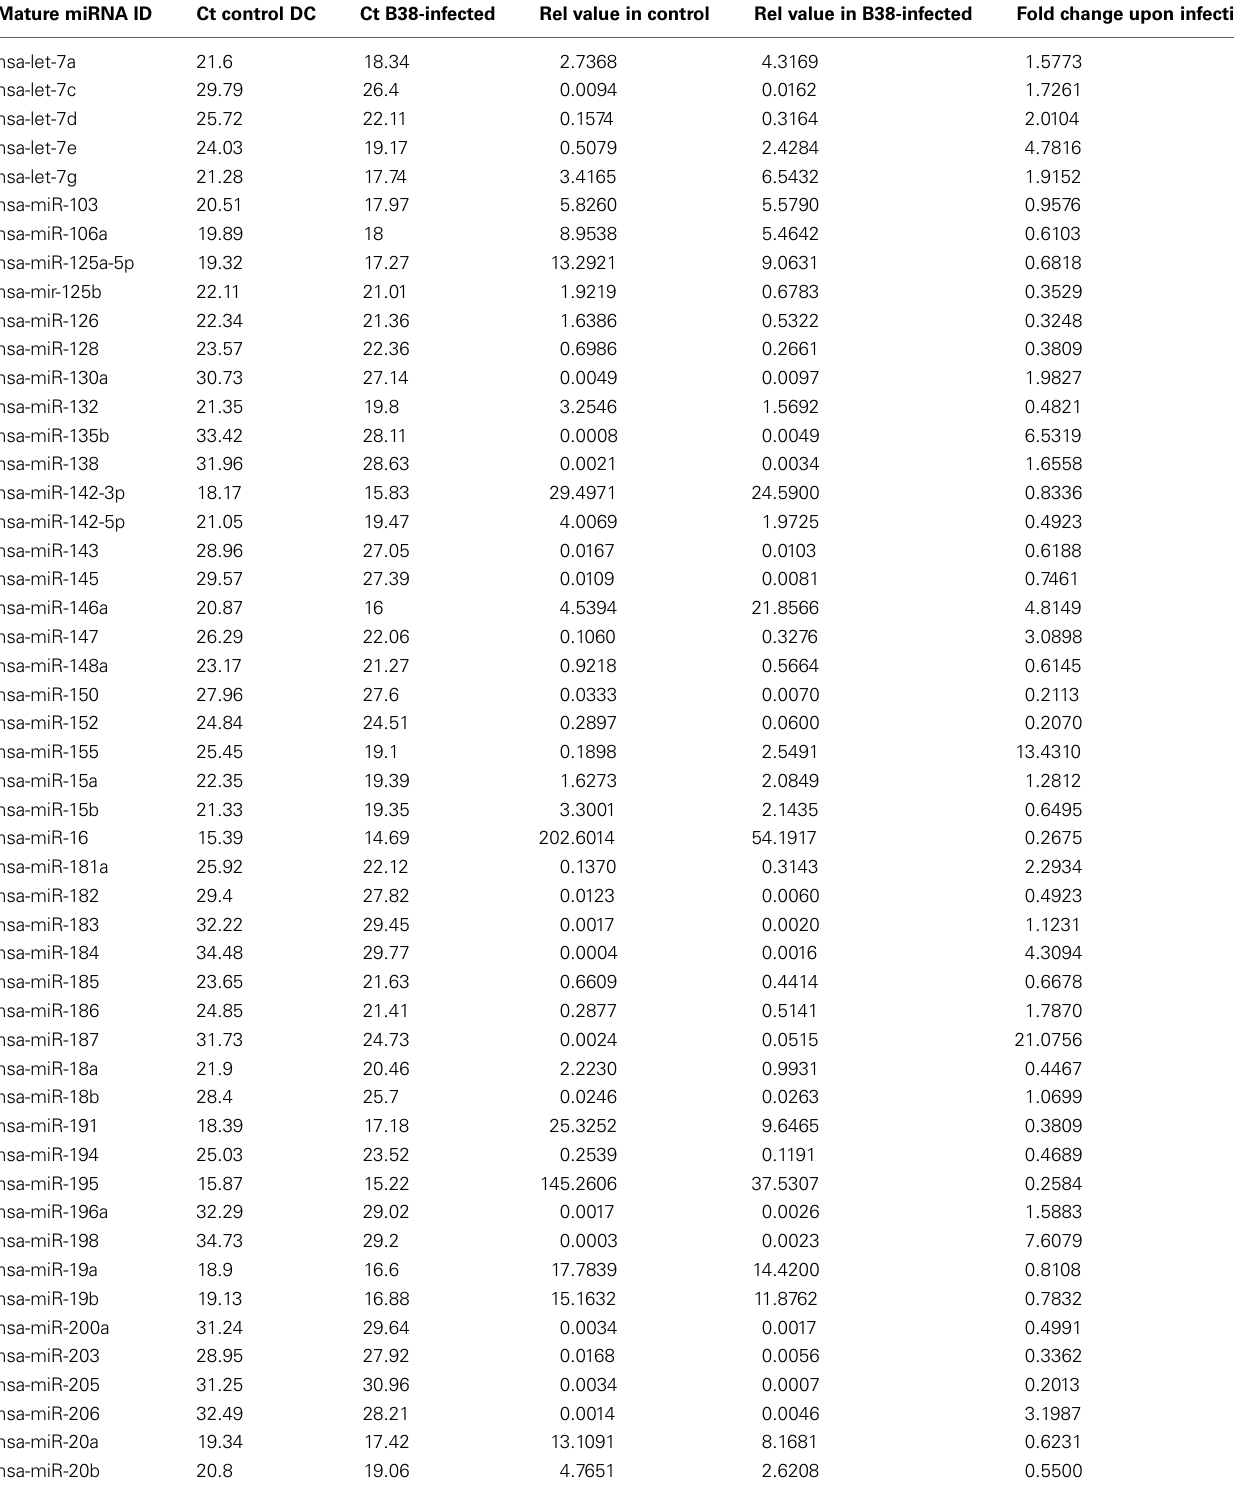
Table A1 | MiRNA microarray data in uninfected DC (control) and DCs infected for 48h by H. pylori B38 strain at MOI 1. Mature miRNA